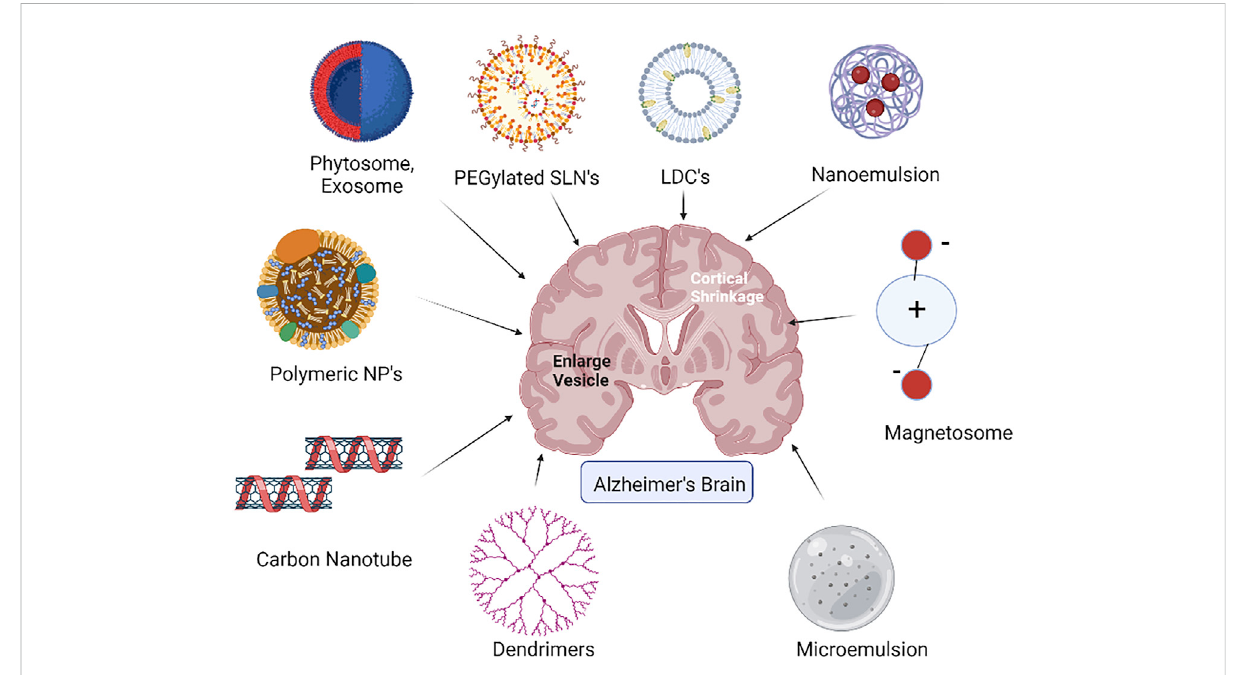
FIGURE 2 Diverse nanocarriers for the effective nose-to-brain delivery in Alzheimer ’ s